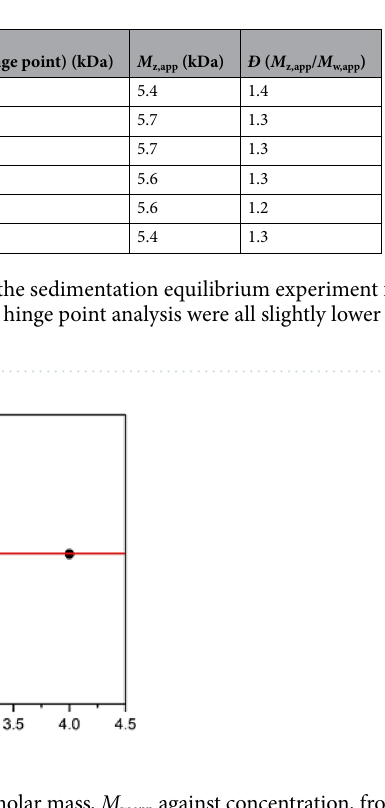
Figure 3. A plot of the apparent weight average molar mass, M w,app against concentration, from sedimentation equilibrium. The M w,app values were not significantly concentration-dependent, meaning that they were not affected by non-ideality. The ideal value was therefore taken as the average (red line), M w = (4.3 ± 0.2) kDa. The data was analysed with SEDFIT-MSTAR using the M * method to obtain the shown M w,app values. Rotor speed = 45,000